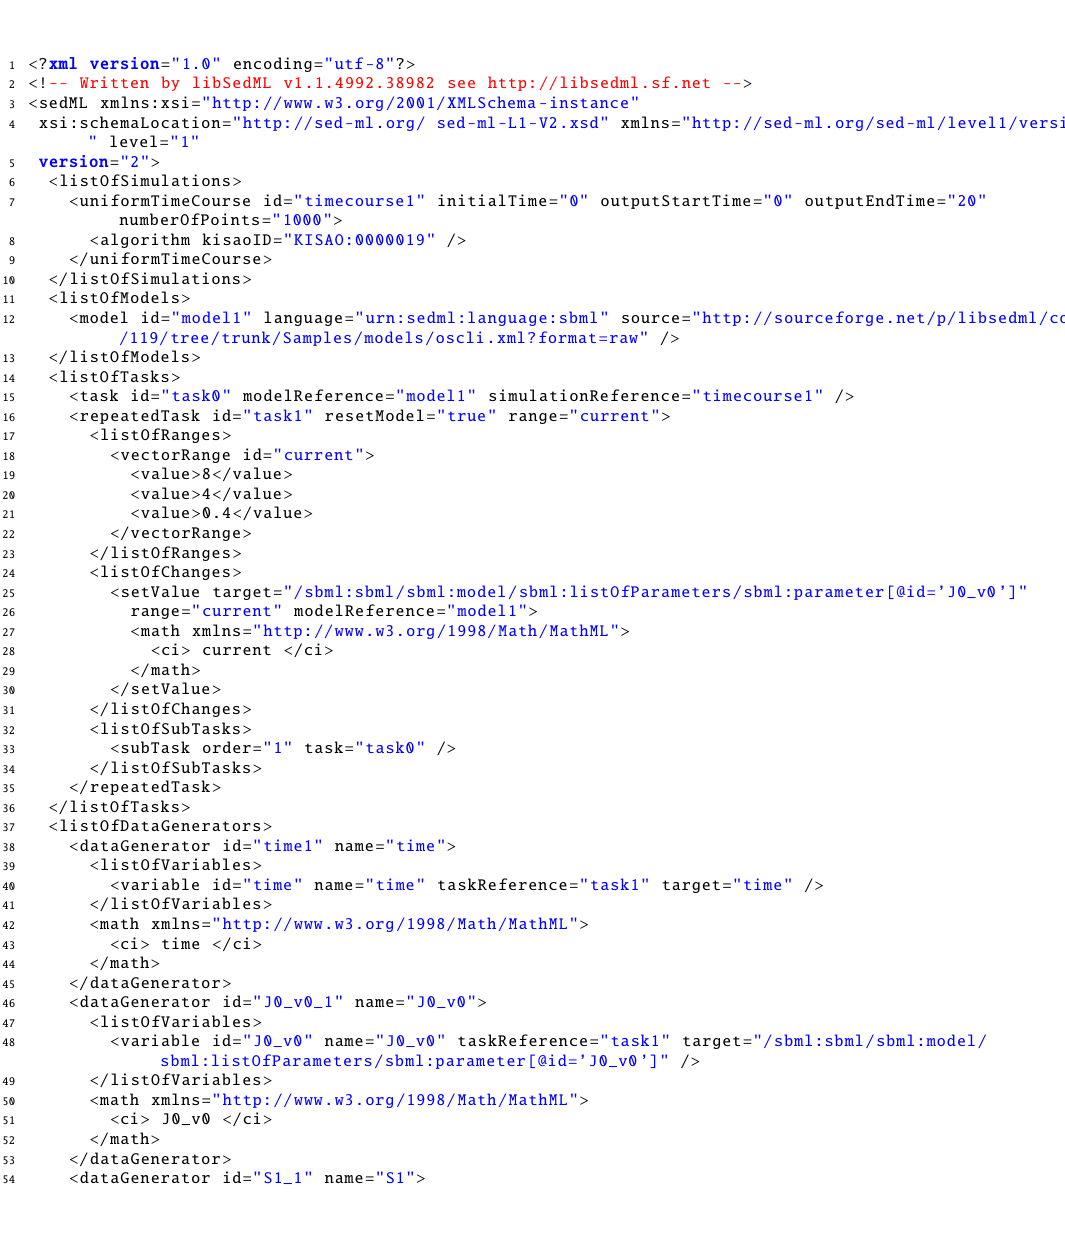
Figure C.7: The simulation result gained from the simulation description given in Listing